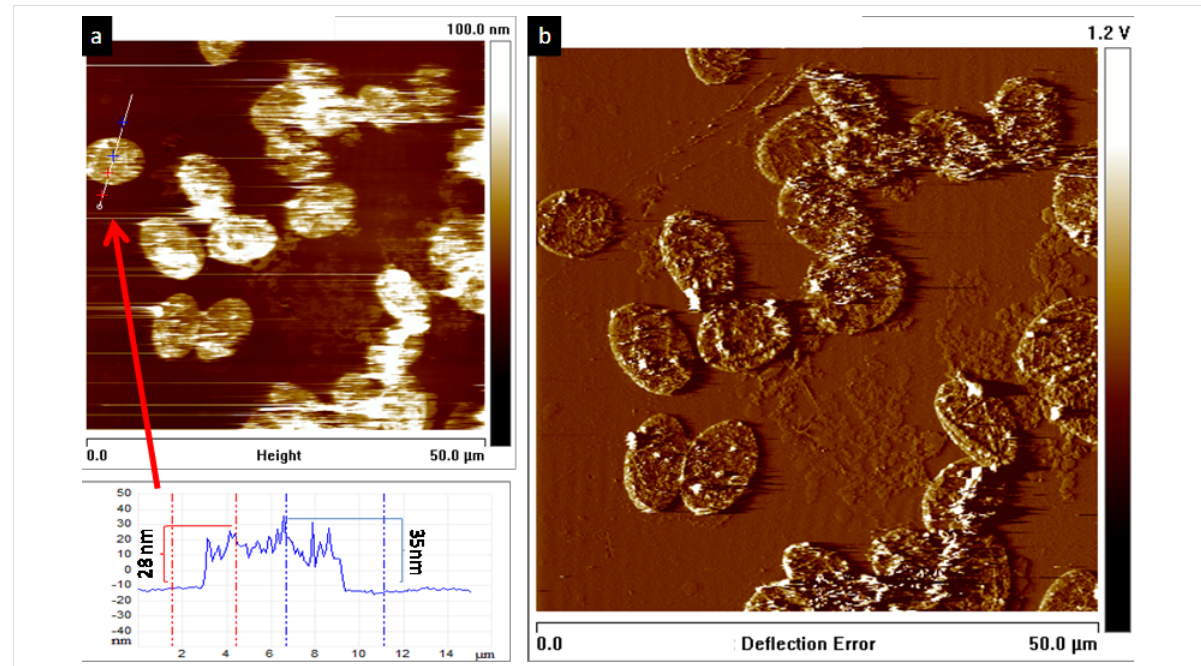
Figure 6: Atomic force microscope images of dried hybrid PE/GO capsules. a) Height image of a 50 × 50 µm scan, with a profile corresponding to the line drawn in the image. b) Deflection image of the same area analysed in a).